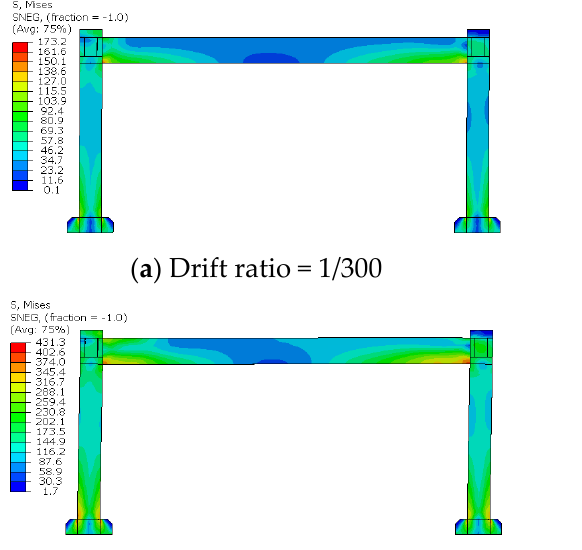
specimen 2. Figure 8 shows the stress nephogram of the steel frame of specimen 1 at a typi- cal displacement ratio. The areas with large stress are mostly concentrated near the node at the beam end and the bottom of the column, and the stress at the beam end is slightly higher than the stress at the bottom of the column; therefore, the beam end yields before the column end. The numerical simulation results are consistent with the experimental observation results. The drift ratio is calculated using the deformation to height ratio. At a drift ratio of 1/100, the maximum stress at the end of the steel beam is 367 MPa, indicating that the frame beam has yielded at this time, whereas the maximum stress at the end of the frame column is 281 MPa, indicating that it has not yet yielded. When the drift ratio reaches 1/75, the maximum stress at the bottom of the frame column is 355 MPa, which exceeds the yield stress of steel and indicates that the frame column has entered the yield stage. When the drift ratio reaches 1/37.5, the beam end and column bottom end of the structure have all yielded and entered the strengthening stage, indicating that the structure formed plastic hinges and failed.